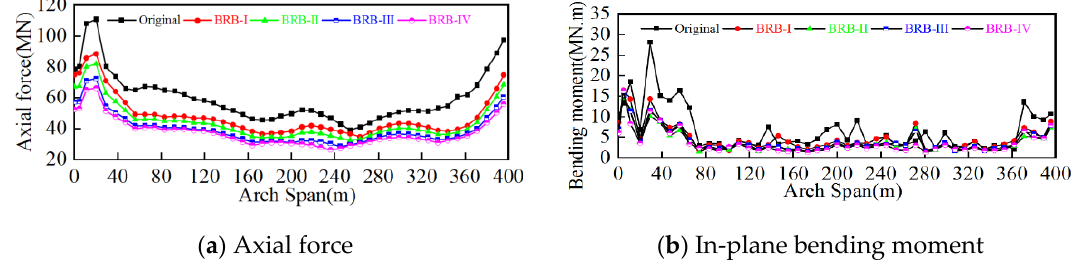
Figure 16. Envelope results of internal force under TCU102 ground motion.